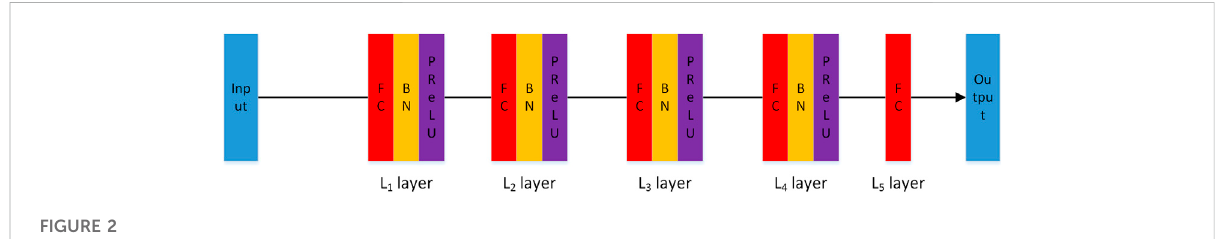
FIGURE 2 The detailed structure of the surrogate